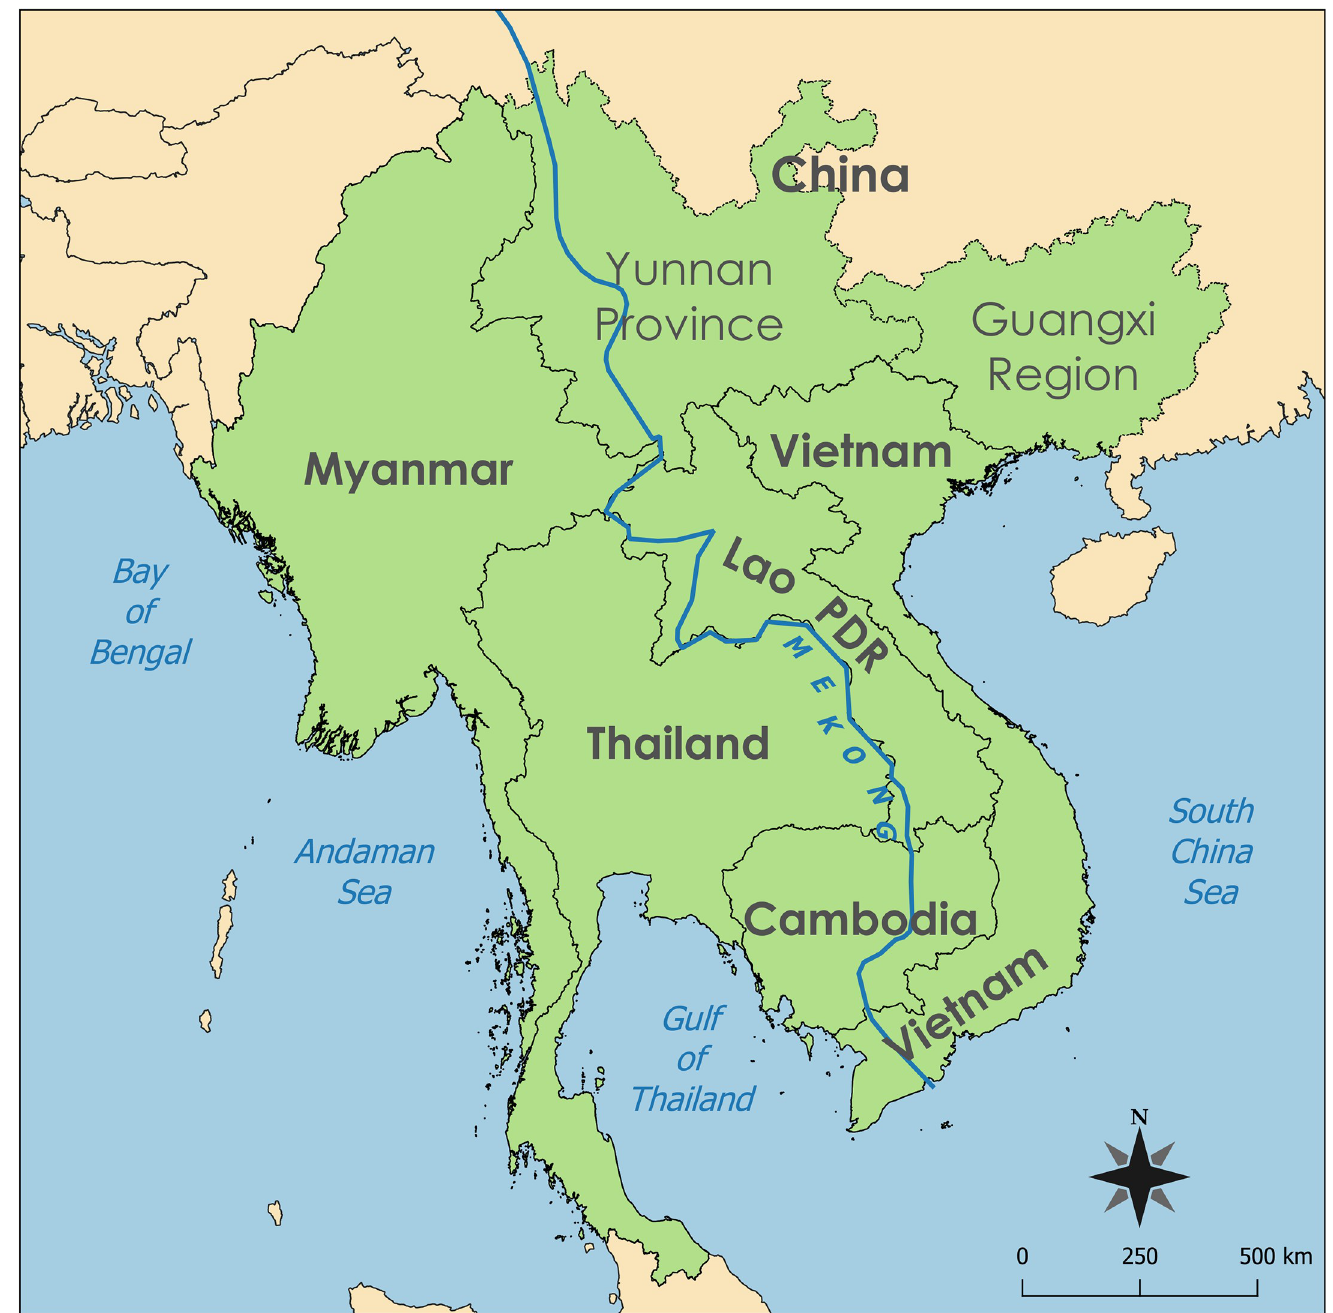
Fig 1. GMS. The map was made using QGIS version 3.4 (https://qgis.org). All map layers were created by one of the coauthors.